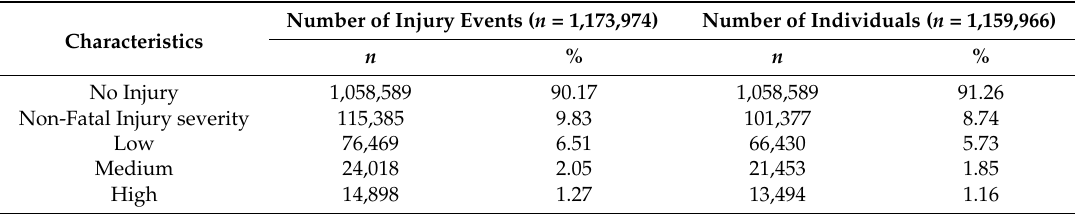
Table 2. Number of individuals and non-fatal injury events by injury severity, 2013.